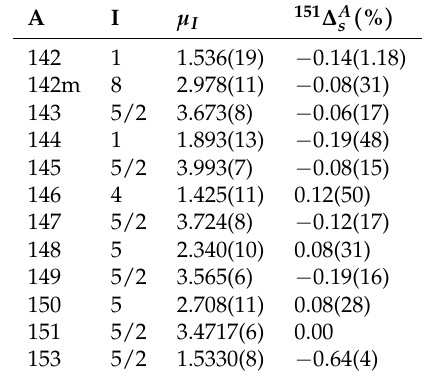
Table 2. Magnetic moments and hyperfine anomalies for Eu isotopes, obtained from Ahmad et al. [25]. A I µ I 151 ∆ A s ( % ) 142 1 1.536(19) − 0.14(1.18) 142m 8 2.978(11) − 0.08(31) 143 5/2 3.673(8) − 0.06(17) 144 1 1.893(13) − 0.19(48) 145 5/2 3.993(7) − 0.08(15) 146 4 1.425(11) 0.12(50) 147 5/2 3.724(8) − 0.12(17) 148 5 2.340(10) 0.08(31) 149 5/2 3.565(6) − 0.19(16) 150 5 2.708(11) 0.08(28) 151 5/2 3.4717(6) 0.00 153 1.5330(8) −